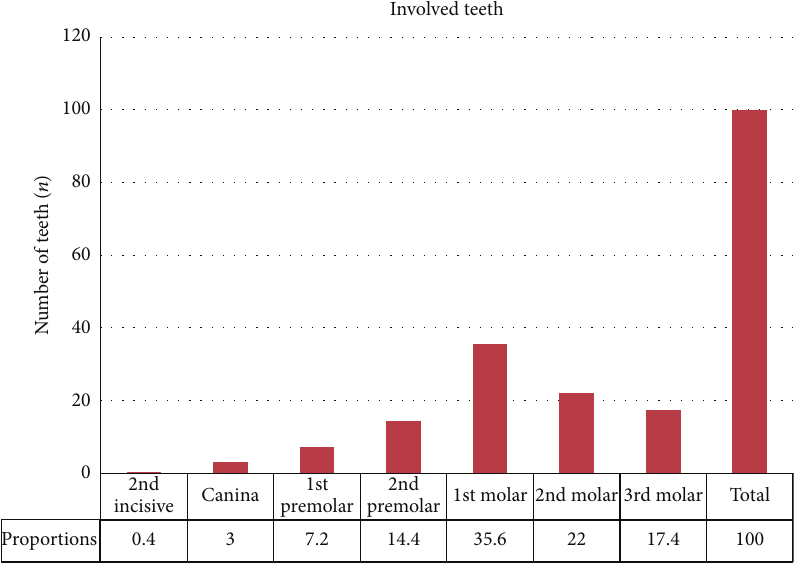
Figure3: Involvedteeth. Thefirstandsecondmolarswerethemostcommonlyaffectedteethrepresenting35.6%and22%ofcases,respectively. They are followed by the third molar (17.4%), the second premolar (14.4%), and the first premolar (7.2%). The canina (3%) and the second incisiva (0.4%) remain rare and